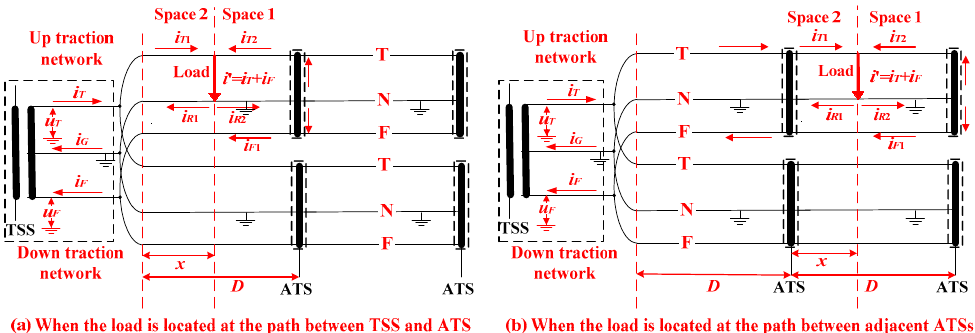
Figure 3. Currents of AT double-track system in a high-speed railway (HSR).